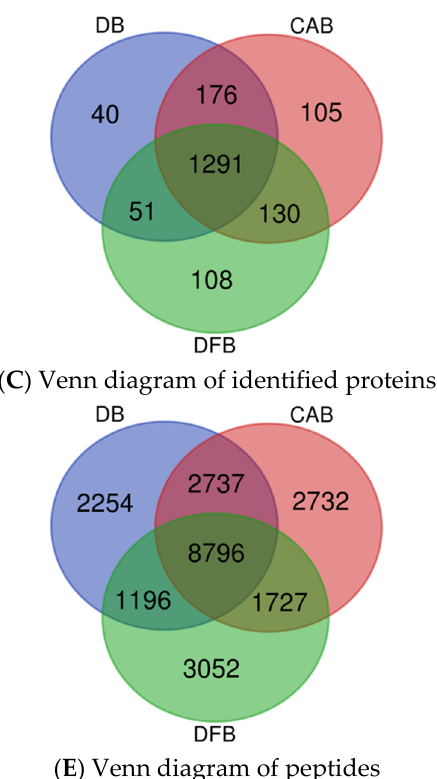
Table 2. Number of proteins, divided in GO categories, identified in each type of homogenate.